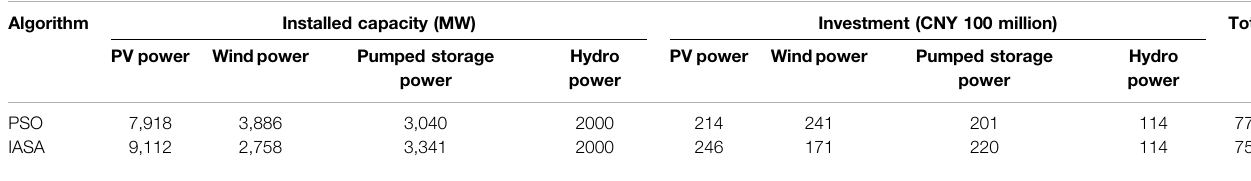
TABLE 5 | Comparison of various installed capacity allocation schemes and investment. Algorithm Installed capacity (MW) PV power